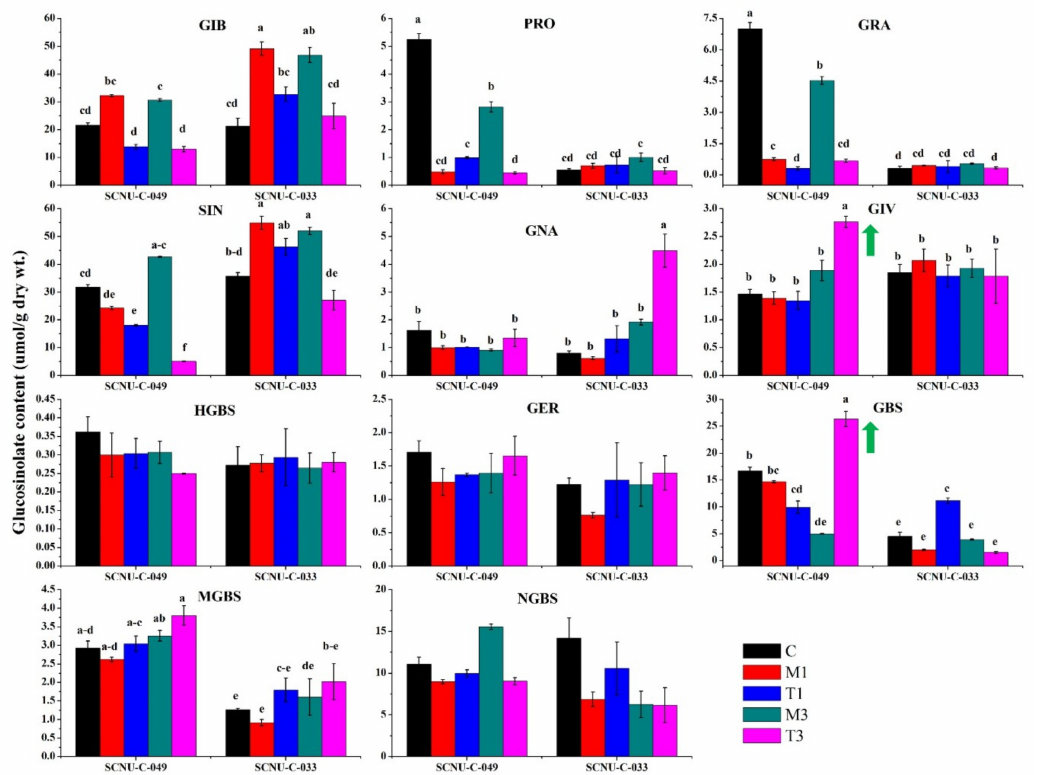
Figure 2. Contents of 11 individual glucosinolates in leaf samples from R (SCNU-C-049) and S (SCNU-C-033) lines of cabbage under different treatment conditions (C, control; M1, mock day 1; T1, treated day 1; M3, mock day 3; T3, treated day 3). The means of three biological replicates are presented. Vertical bars indicate standard deviation. Different letters indicate statistically significant differences between R and S lines and treatment interactions. Upward-pointing green arrows indicate increased glucosinolate content of R line in response to S. sclerotiorum infection. R, resistant; S, susceptible. HPLC–mass spectrometry (HPLC-MS) analysis (using an Agilent 1200 series instrument,